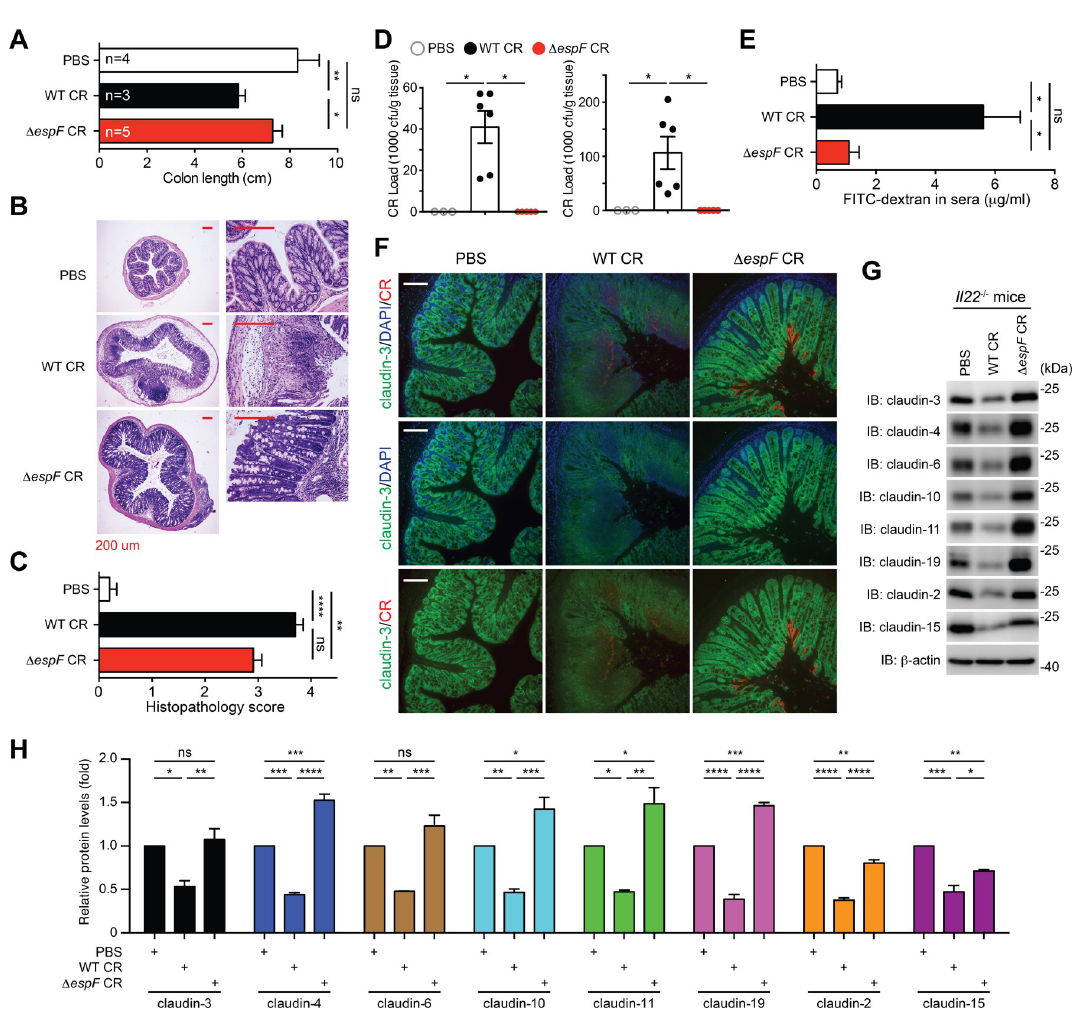
Fig 3. CR infection disrupts tight junction integrity in the colon in an EspF-dependent manner. A. Colon length of Il22 -/- mice, inoculated with phosphate-buffered saline (PBS) (n = 4), wild-type (WT, n = 3) or Δ espF (n = 5) CR, and euthanized at 7 days post inoculation (dpi). B . Hematoxylin and eosin staining of colons derived from Il22 -/- mice infected as in (A). Scale bars, 200 μ m. C. The histopathology scores of colon sections derived from Il22 -/- mice infected as in (B). Shown are mean ± s.e.m of 10 random fields from two independent experiments. D. The CR burden in the liver (left) and the spleen (right) derived from Il22 -/- mice, infected as in (A) at 7 dpi, were quantified. E. Serum levels of FITC-dextran, assessed at 4 h post oral administration, in Il22 -/- mice infected with PBS (n = 5), WT CR (n = 9), or Δ espF CR (n = 4) at 7 dpi. F. Immunofluorescence micrographs of claudin-3 in the colons collected from Il22 -/- mice, infected as in (A) at 7 dpi, with nuclei counterstained by DAPI. Scale bars, 100 μ m. G. Il22 -/- mice were infected as in (F), and colon epithelial cell lysates were derived and IB for indicated claudins, with β -actin as a loading control. H. The protein levels of indicated claudins, normalized to β -actin and PBS controls, were quantified by ImageJ software from three independent experiments. ns, not significant; � p < 0.05, �� p < 0.01, ��� p < 0.001, and ���� p < 0.0001 with one-way analysis of variance, followed by Bonferroni’s multiple comparison tests (A, D-E, H), and with Kruskal-Wallis test followed by Dunn’s multiple comparisons tests